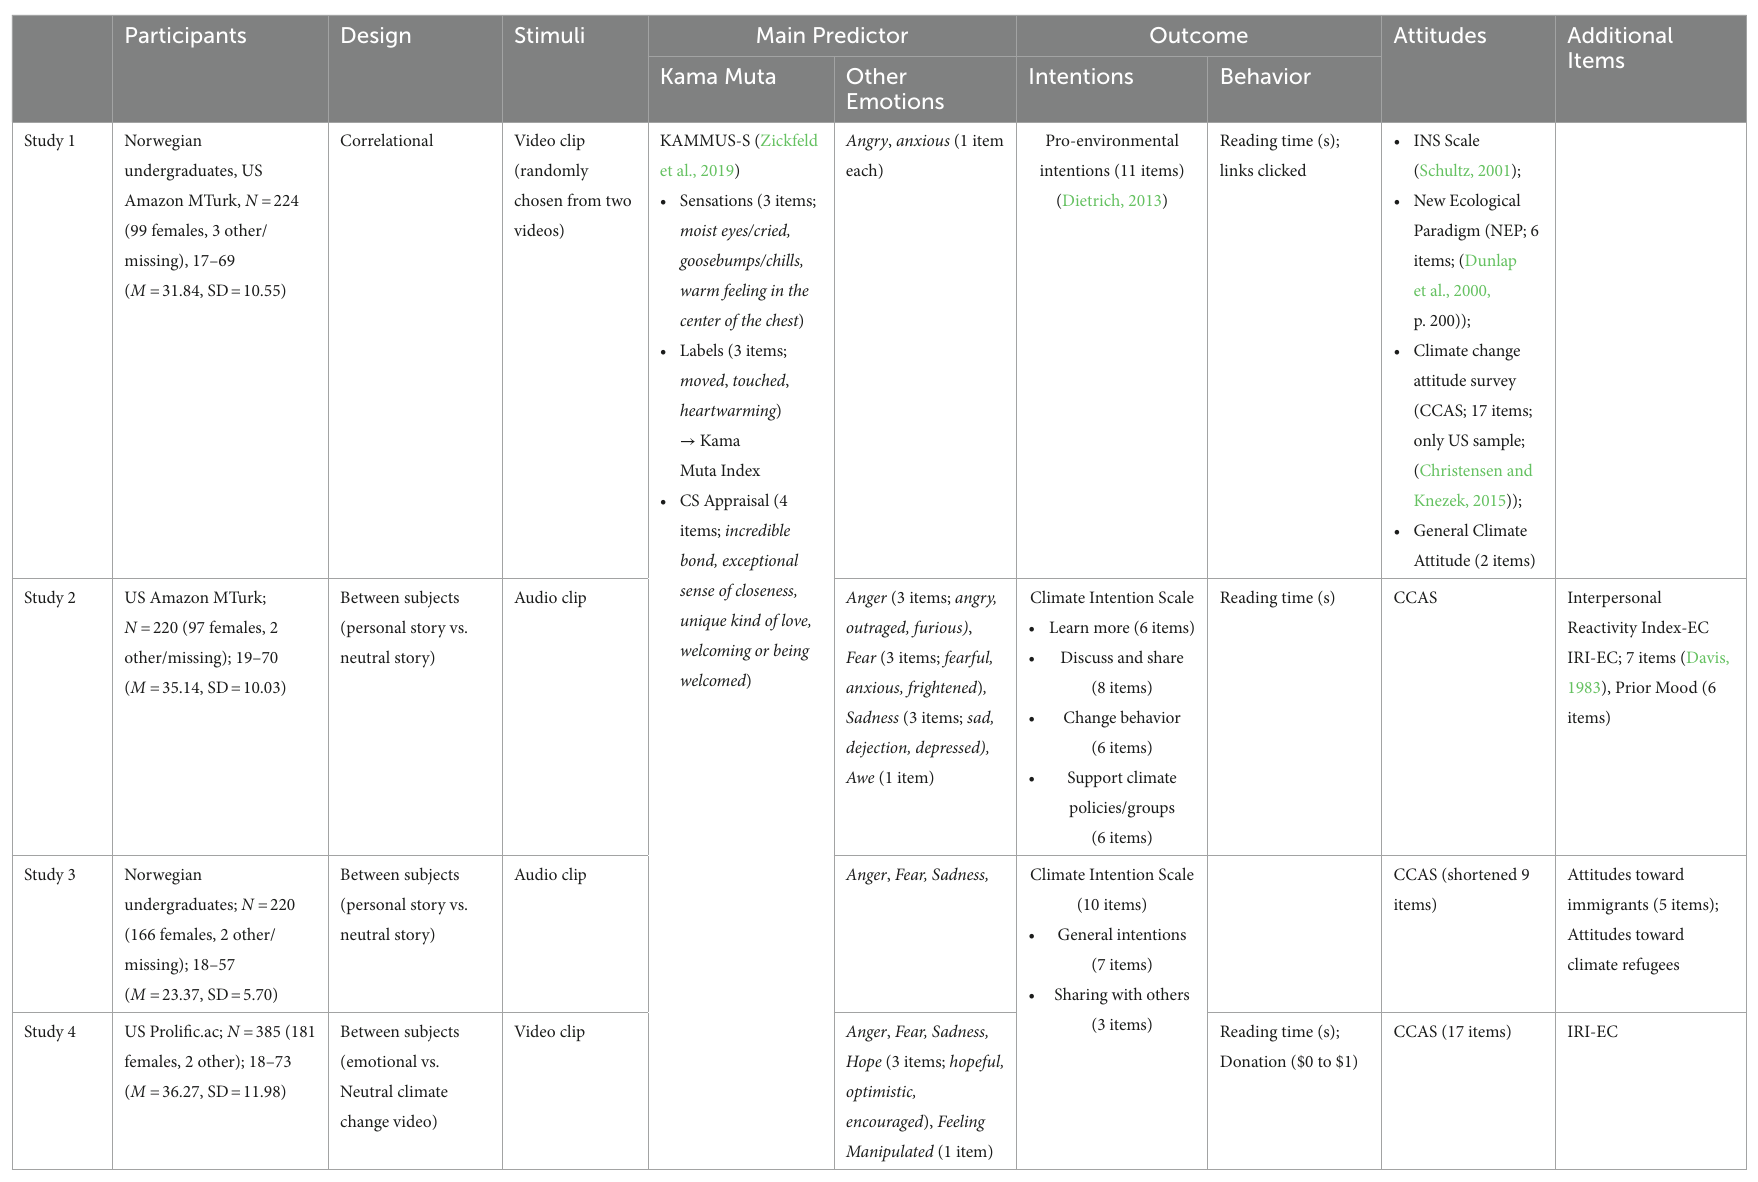
TABLE 1 Overview of the stimuli and measures used in Studies